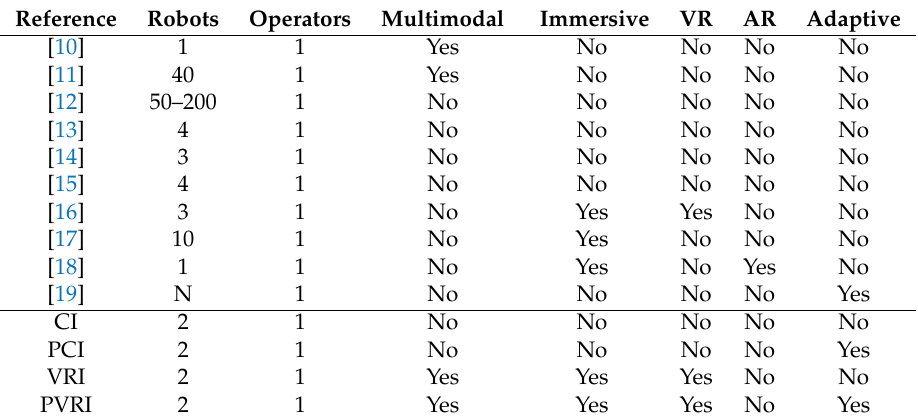
Table 2. The interfaces of this work, against a diverse set from